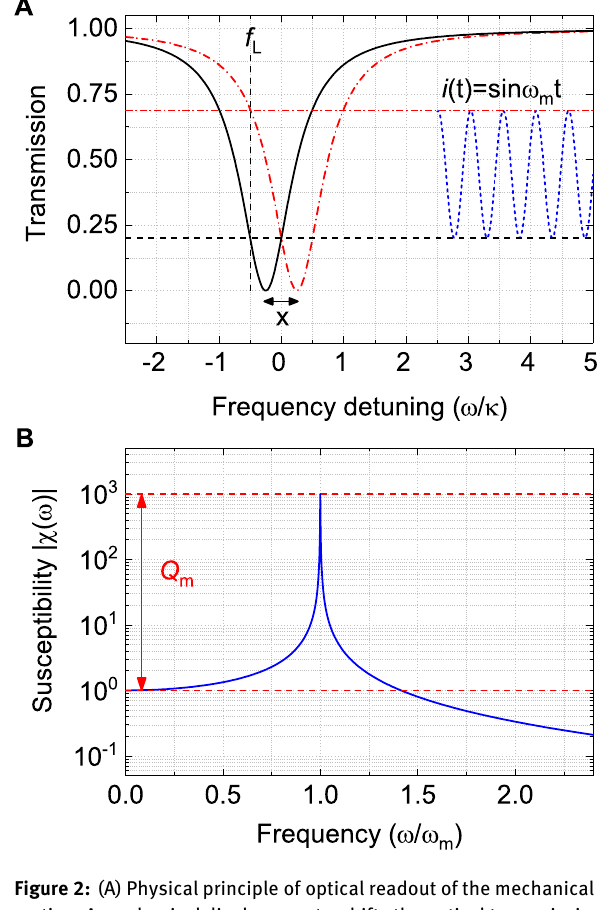
Figure 2: (A) Physical principle of optical readout of the mechanical motion. A mechanical displacement x shifts the optical transmission spectrum from the black solid curve to the red dash-dotted curve. The periodic mechanical motion therefore cause a modulation of the output photocurrent i ( t ), when the laser frequency f is locked on L the side of the optical resonance. (B) Susceptibility | 𝜒 ( 𝜔 ) | of a mechanical resonator as a function of the frequency, normalized to its zero frequency susceptibility | 𝜒 (0) | . The susceptibility on the mechanical resonance is enhanced by a factor of mechanical quality compared to that at zero factor Q m